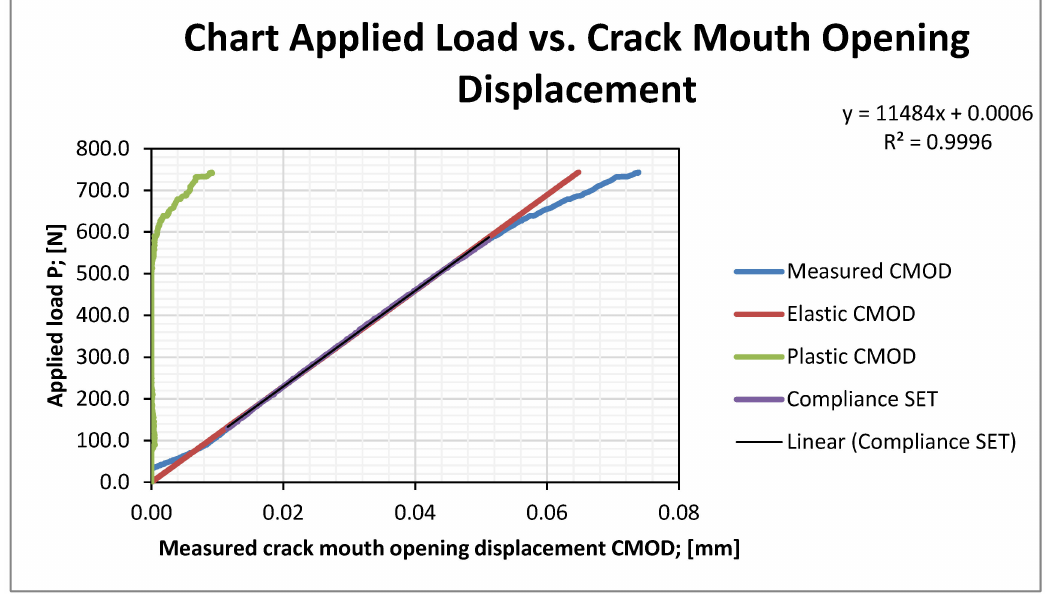
Figure 6. Force/CTOD (crack tip opening displacement) plot of test sample.